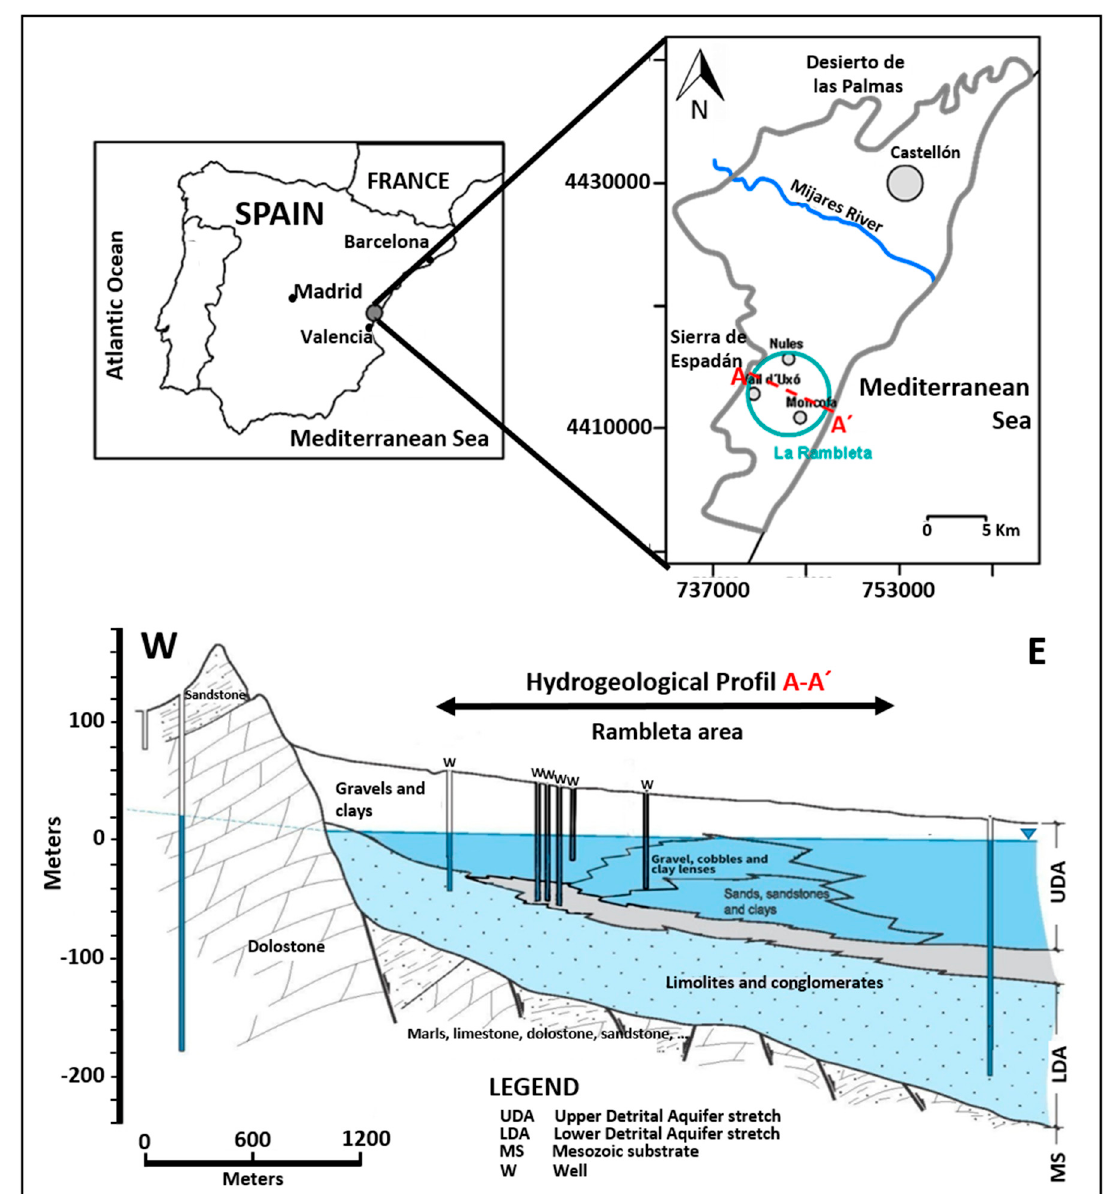
Figure 1. The situation of the study area (the Rambleta area, Plana de Castellón aquifer, Spain) and a hydrogeological cross-section through the study area [50].